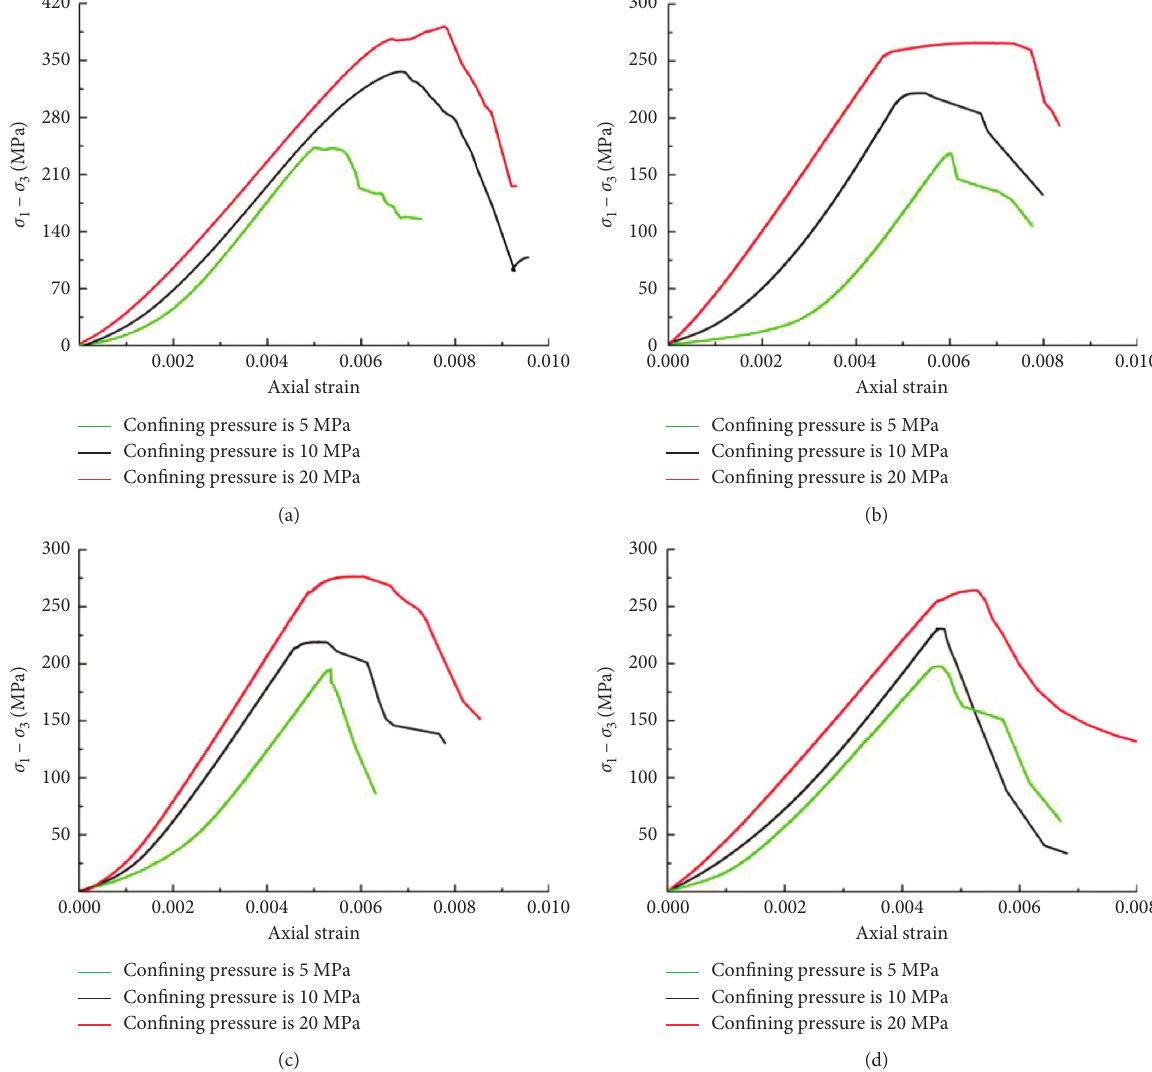
Figure 5: Deviatoric strain-stress curve of sandstone specimens under different confining pressure unloading rates. (a) Triaxial com- pression. (b) (v) � 0.002MPa/s. (c) (v) � 0.02 MPa/s. (d) (v) � 0.2 MPa/s.